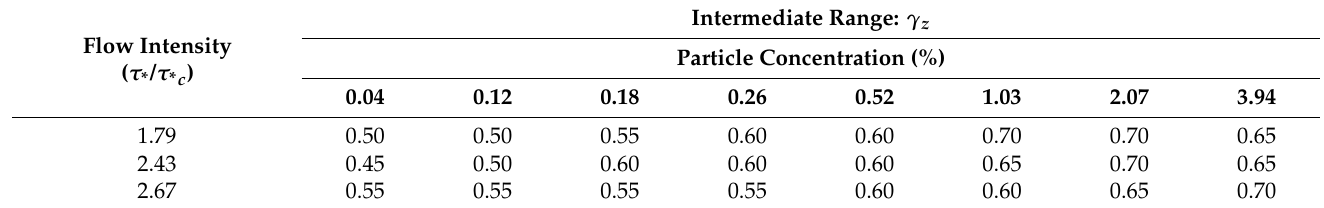
Table 7. Summary of values for γ z for particle diffusion in the intermediate range in the Z-axis.